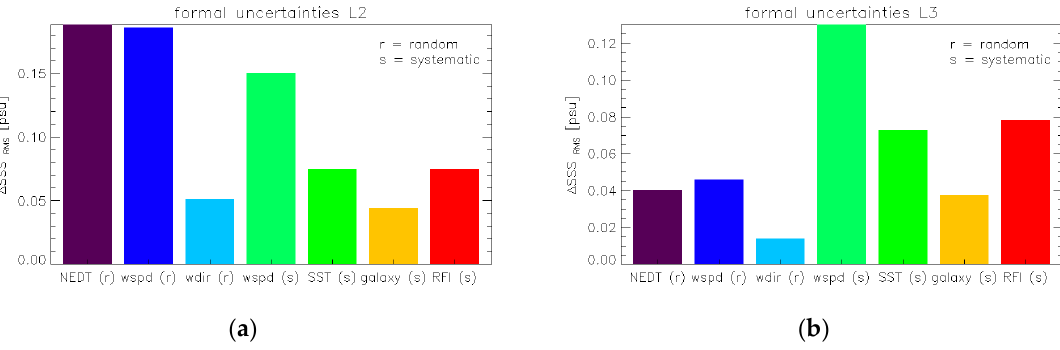
Figure 12. Contribution of the various uncertainties to the total estimated uncertainty for open ocean scenes of: ( a ) the Aquarius Level 2 salinity that is observed at the 1.44 s cycle; ( b ) the 1° Aquarius Level 3 salinity maps.